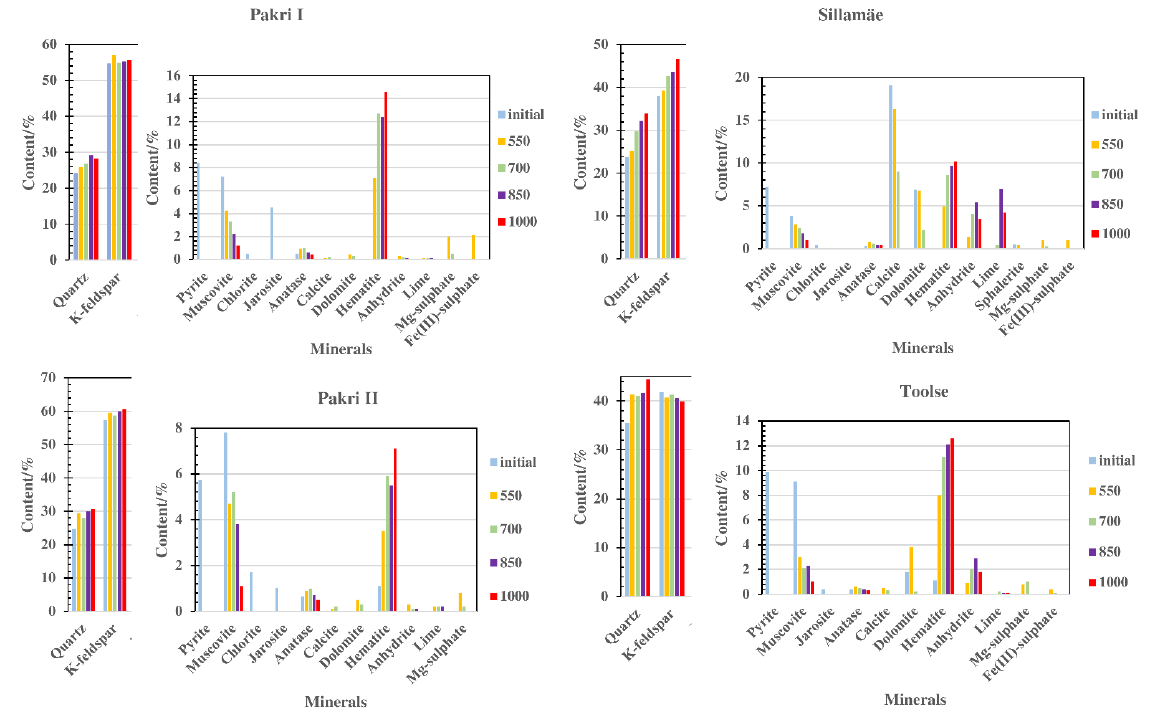
Figure 6. Changes in the mineralogical composition of GA samples thermally treated at different ent temperatures.